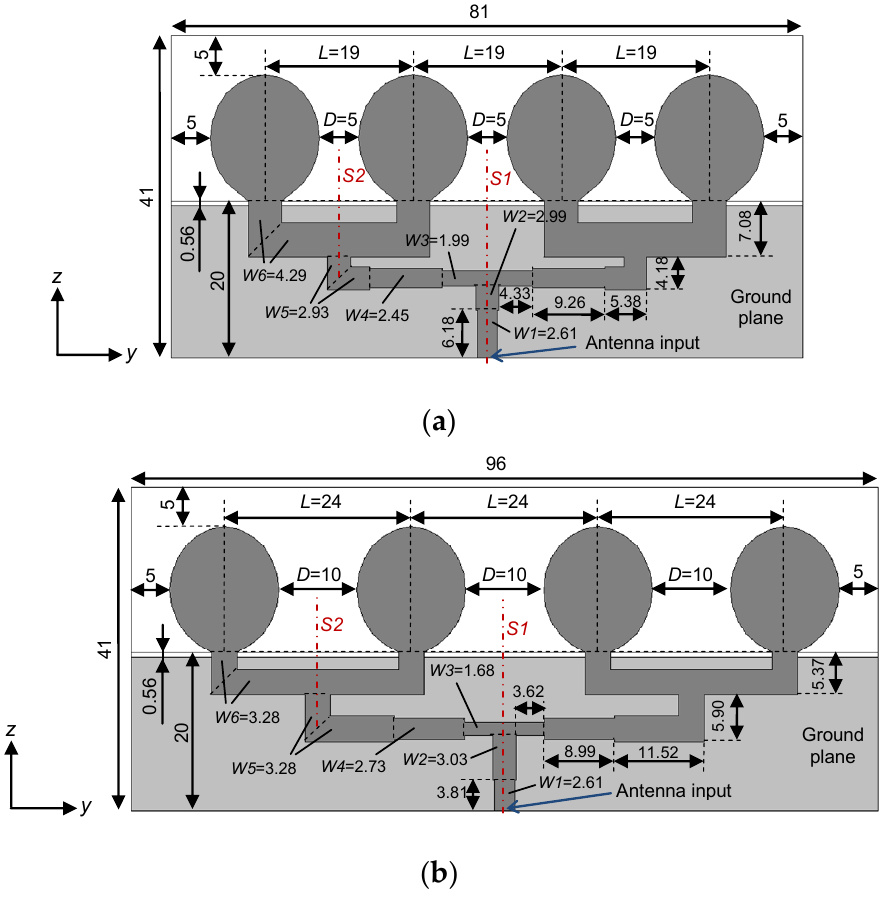
Figure 2. Geometry of proposed four-element antenna arrays in yz -plane (dimensions in mm): ( a ) Shorter variant of UWB antenna array; ( b ) Longer variant of UWB antenna array. For two considered antenna array variants the centers of the radiators are positioned in the distance: L = 19 mm (shorter variant) and L = 24 mm (longer variant). The distances between the radiators’ edges on the y -axis are thus D = 5 mm and D = 10 mm, respec- tively. The electrical length between the centers of neighboring radiating elements varies throughout the operation frequency range from 0.38 λ at 6 GHz to 0.54 λ at 8.5 GHz for the shorter variant and from 0.48 λ at 6 GHz to 0.68 λ at 8.5 GHz for the longer variant ( λ is the free-space wavelength). The overall dimensions of both variants of the four-element UWB antenna arrays are 81 mm × 41 mm for the shorter variant and 96 mm × 41 mm for the longer variant. The single input of each array variant is placed in the middle of the bottom edge of each array variant structure. Ports dedicated to stripline structures were used again as the arrays’ inputs in the computer analysis without modeling SMA connectors. The length of the excitation section measured along the z -axis, from the bottom of the